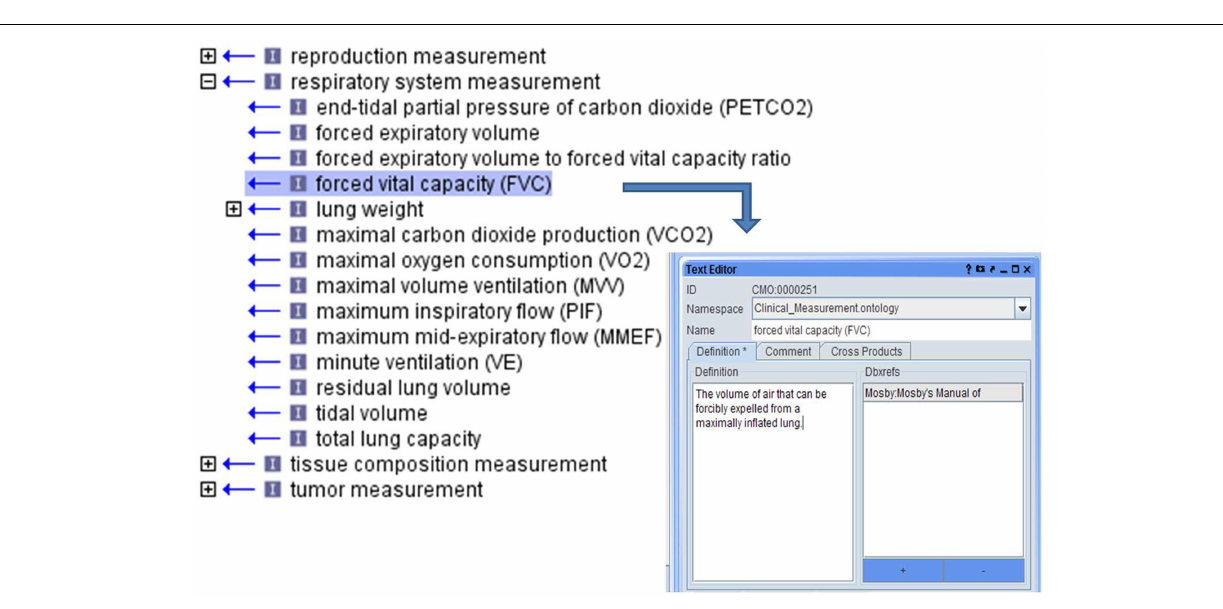
FIGURE 3 | Each CMO term was created as phenotype domains addressed with appropriate definitions for each term.